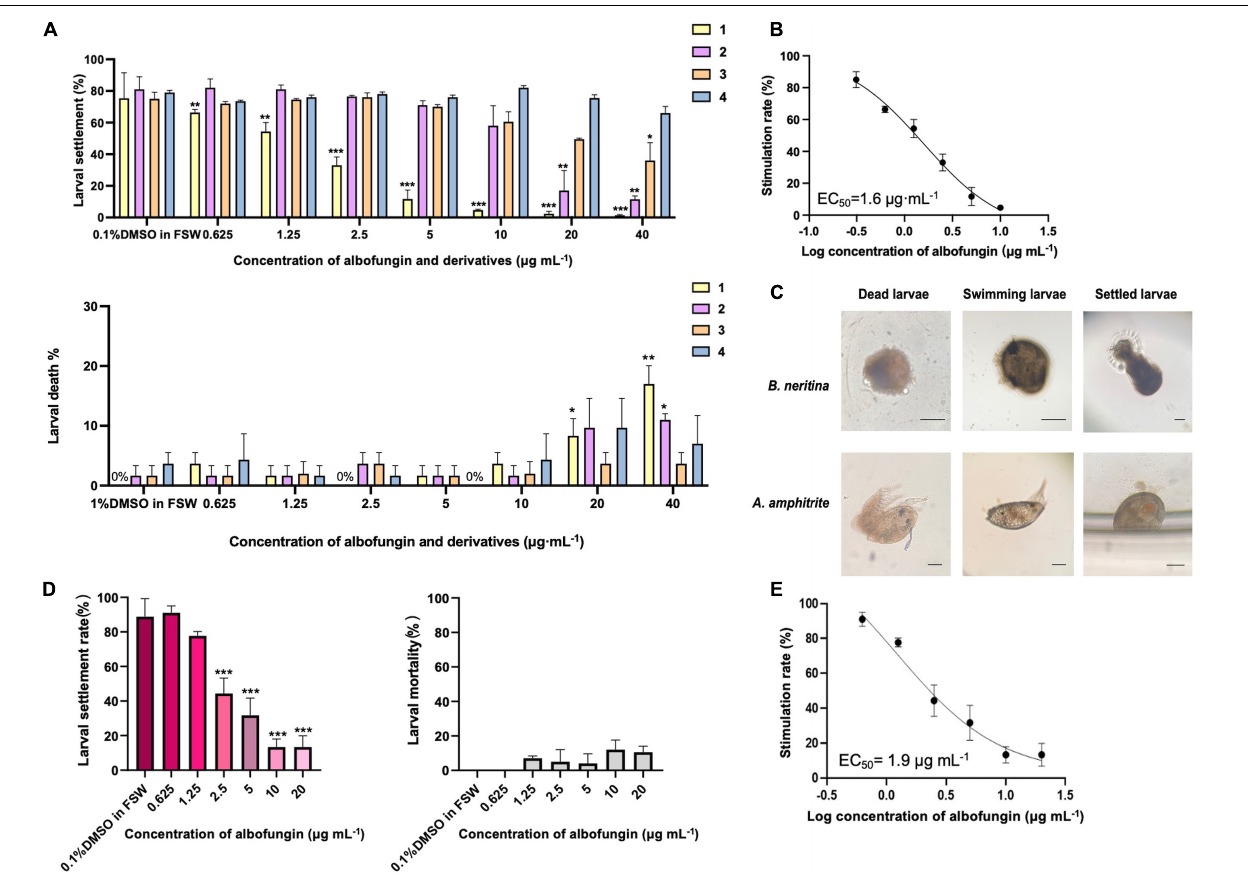
FIGURE 3 | Antifouling activity of albofungins ( 1 – 4 ) against barnacle Amphibalanus amphitrite and bryozoan Bugula neritina . (A) Larval settlement rate and larval mortality rate of A. amphitrite under the treatment of albofungins ( 1 – 4 ) with concentrations of 0.625–40 µ g mL − 1 for 48 h. Error bars represent SD, n = 9 wells from 3 batches of larval cultures. Significant differences were analyzed by one-way ANOVA, * p < 0.05, ** p < 0.01, and *** p < 0.001. (B) Stimulation rate curve of albofungin ( 1 ) treatment on A. amphitrite larvae. Error bars represent SD, n = 9 wells from 3 batches of larval cultures. (C) Different conditions of A. amphitrite and B. neritina larvae during the bioassay. Scale bars = 100 µ m. (D) Larval settlement rate and larval mortality rate of B. neritina under the treatment of albofungin ( 1 ) with concentrations of 0.625–20 µ g mL − 1 for 3 h. Error bars represent SD, n = 9 wells from 3 batches of larval cultures. Significant differences were analyzed by one-way ANOVA, * p < 0.05, ** p < 0.01, and *** p < 0.001. (E) Stimulation rate curve of albofungin ( 1 ) treatment on B. neritina larvae. Error bars represent SD, n = 9 wells from 3 batches of larval